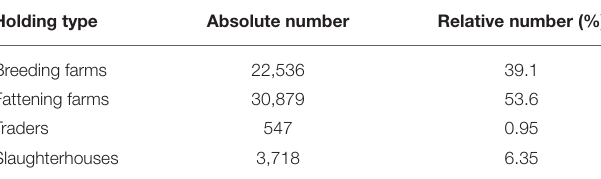
TABLE 2 | Numbers of holding types in the pig trade network. Holding type Absolute number Breeding